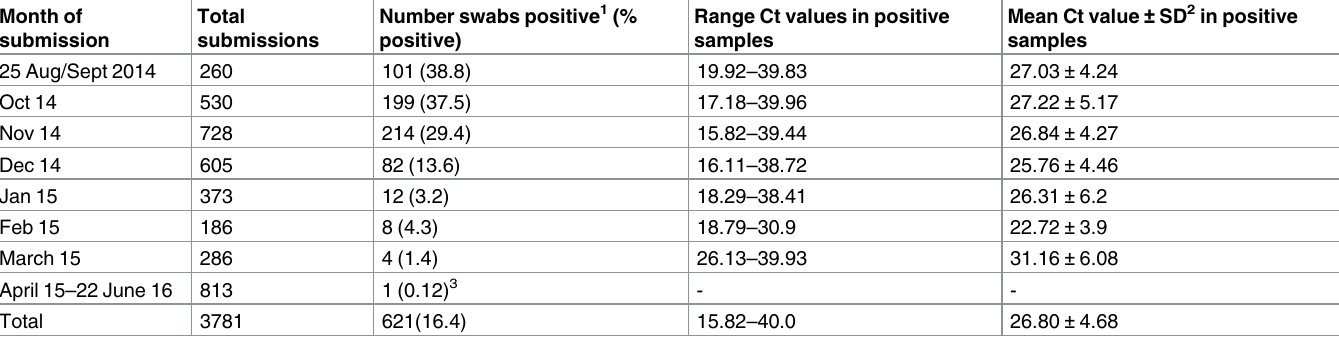
Table 2. Ebola virus polymerase gene TaqMan real-time RT-PCR results in buccal